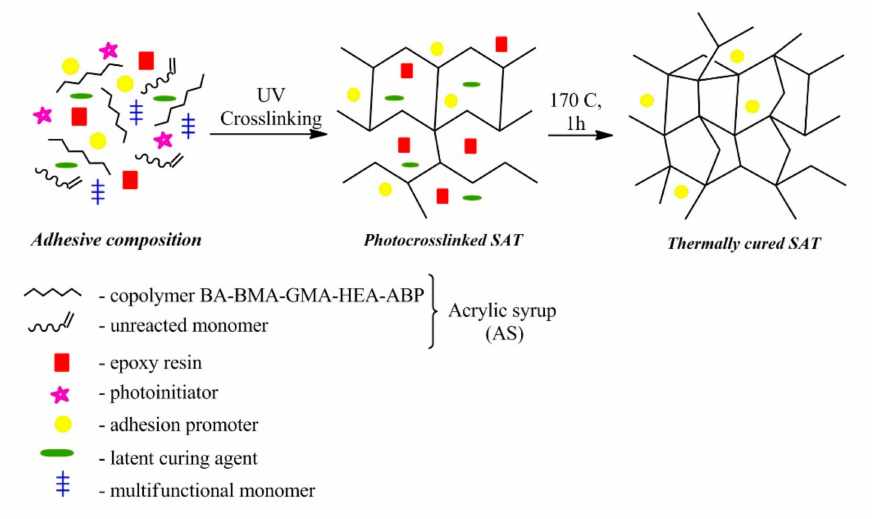
Figure 2. Preparation steps of the self-adhesive structural tapes